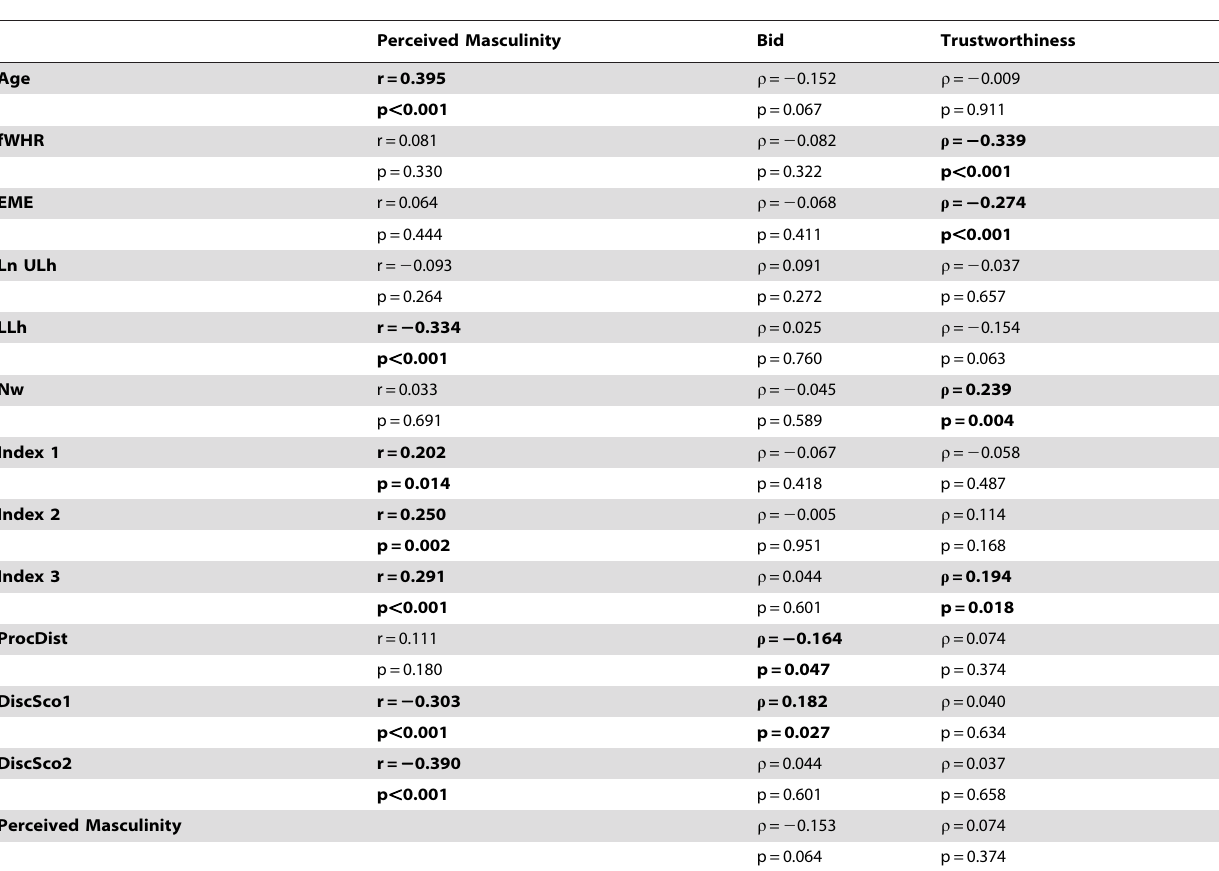
Table 2. Correlations between perceived masculinity, bid and trustworthiness scores with morphometric measures (n=147).